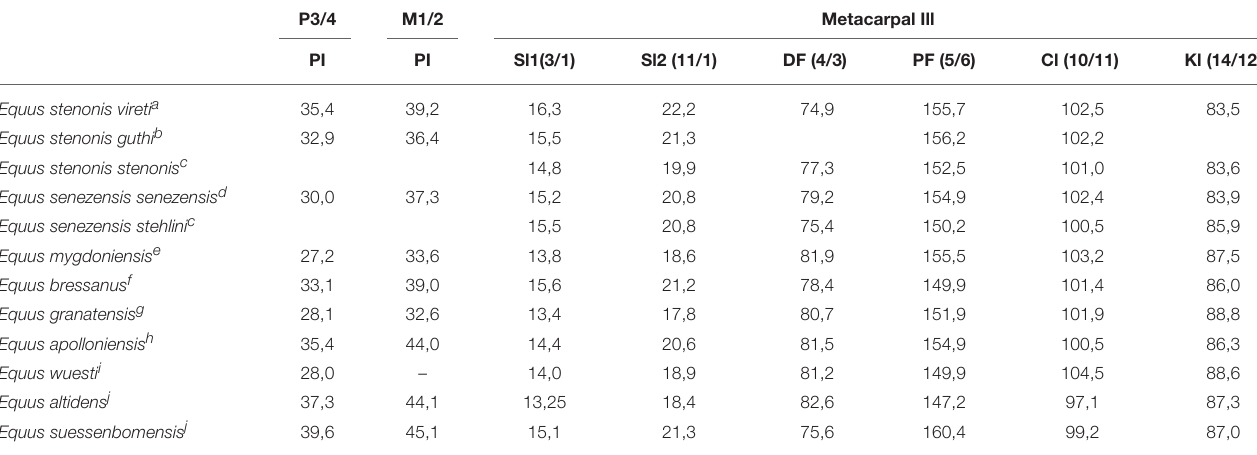
TABLE 1 | Index on teeth and metacarpal for selected Early and Middle Pleistocene